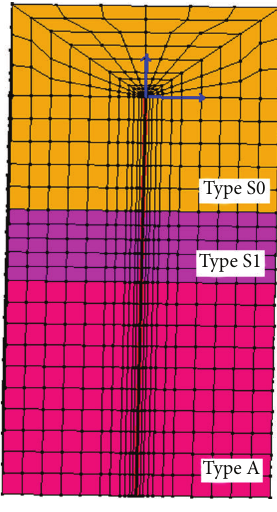
Figure 3: Free-field 3D model.